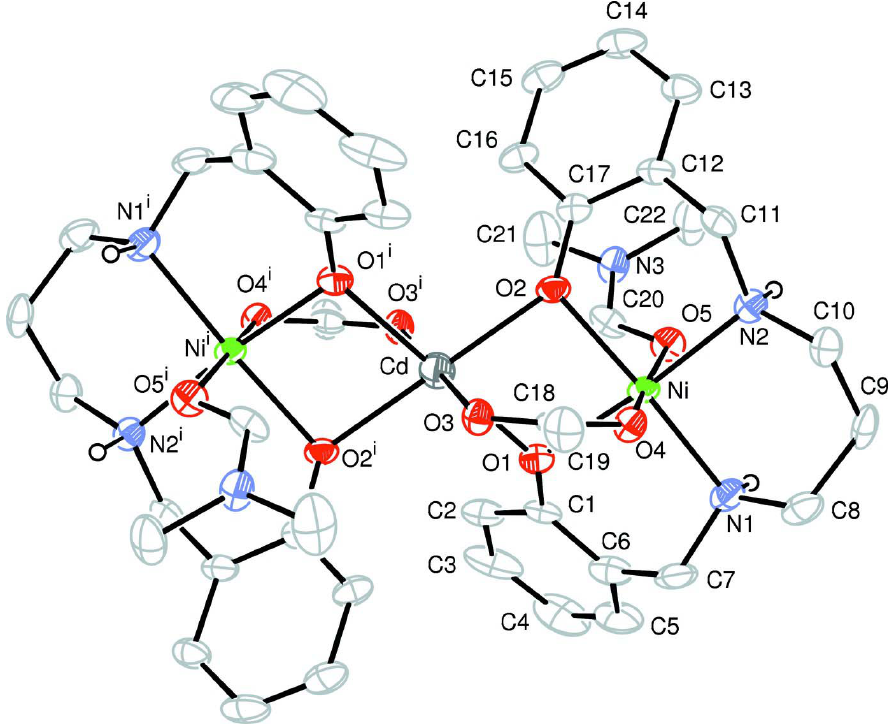
The molecular structure of the title molecule with the atom-numbering scheme. Displacement ellipsoids are drawn at the 30% probability level (symmetry code (i): - x , - y , - z ). H atoms bonded to C atoms are not shown. Di- µ -acetato-1:2 κ 2 O : O ′ ;2:3 κ 2 O : O ′ -bis( N , N ′ -dimethylformamide)- 1 κ O ,3 κ O -bis{ µ 2